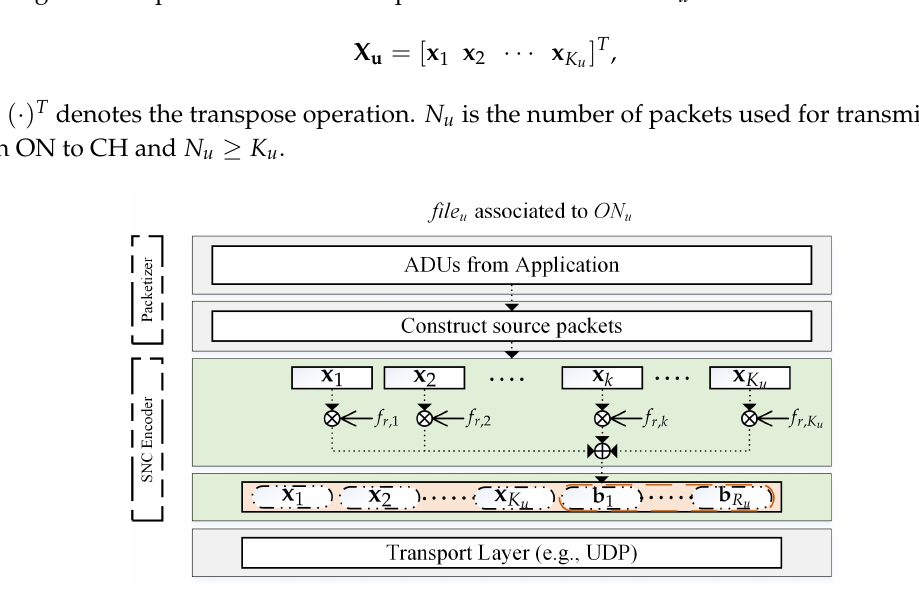
Figure 3. A proposed u th ON’s